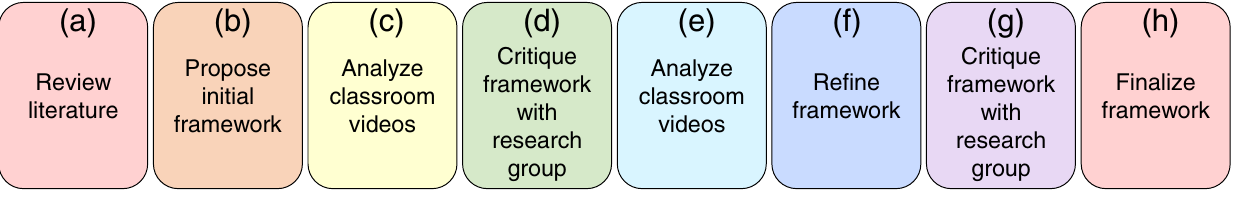
FIG. 1. Timeline of the methodological steps that were taken to develop the CT framework proposed in this report. (a) First, a literature review was conducted to identify works pertaining to computational thinking practices. (b) An initial list of practices was proposed with 17 uncategorized, standalone practices. (c) The initial practices were used to analyze in-class video data and find examples of the practices from students working with computationally integrated physics activities. (d) An initial framework was constructed and shared with external researchers to provide feedback on how the framework could be improved in terms of its relevance and precision of definitions. (e) Classroom videos were analyzed again to find examples that served as evidence for the updated practices. (f) The framework was refined based on findings from in-class data and feedback from researchers. (g) The framework was critiqued by a PER group to discuss its relevance to physics, as well as any confusing language in the framework ’ s definitions. (h) The finalized framework comprised 14 practices in 6